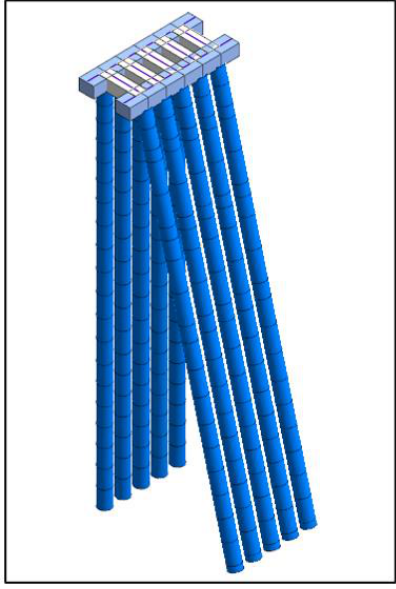
Figure 2. Sketch of the double-row pile.